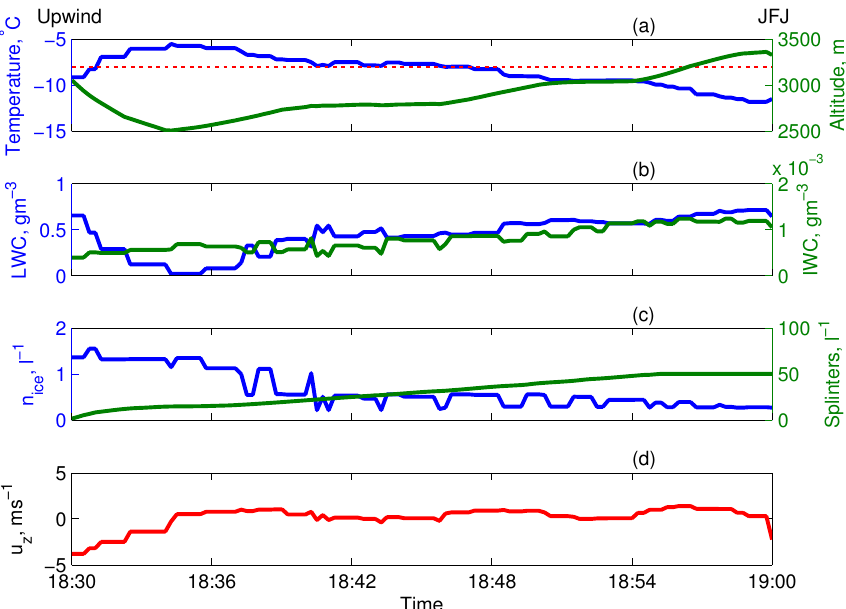
Figure 9. Variations in dynamical and microphysical properties along a back trajectory of air between a point upwind of Jungfraujoch and Jungfraujoch on 1 February 2014, assuming a constant wind field. The constant wind field is taken from the WRF control simulation output of 1 February 2014 at 19:00UTC. (a) Temperature and altitude along the back trajectory, with the red dashed line illustrating the − 8 ◦ C isotherm. (b) LWC and IWC along the back trajectory. (c) Ice number concentration from the WRF control run along the back trajectory, and the cumulative number of splinters produced along the trajectory, calculated using Eq. (4). (d) Vertical wind speed along the back